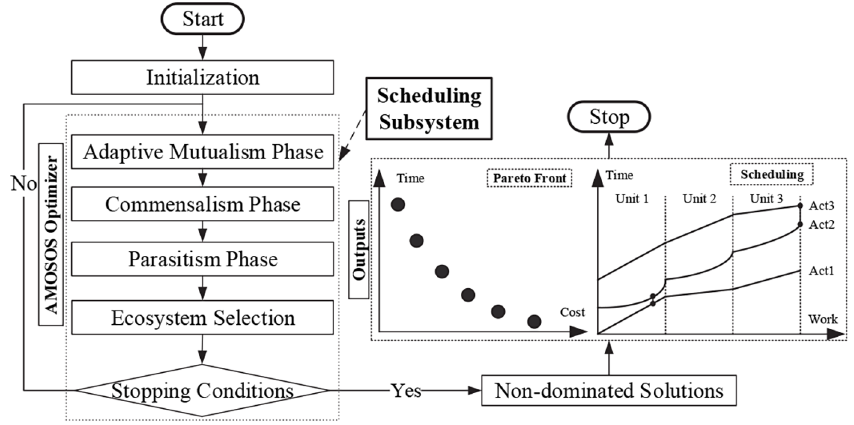
Figure 3. Proposed model for